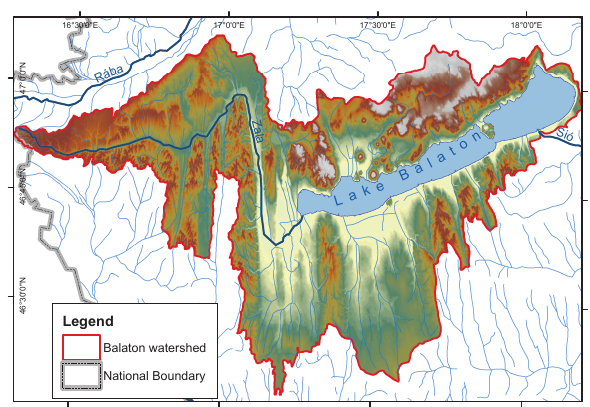
Fig. 1. Lake Balaton and the topography of its watershed. Elevation ranges between 100 and 500m above sea